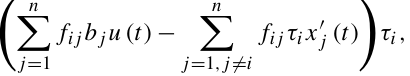
n P f 4 j τ 4 b j u(t) in panels (b–e) and x c , 4 , p (t) = j = 1